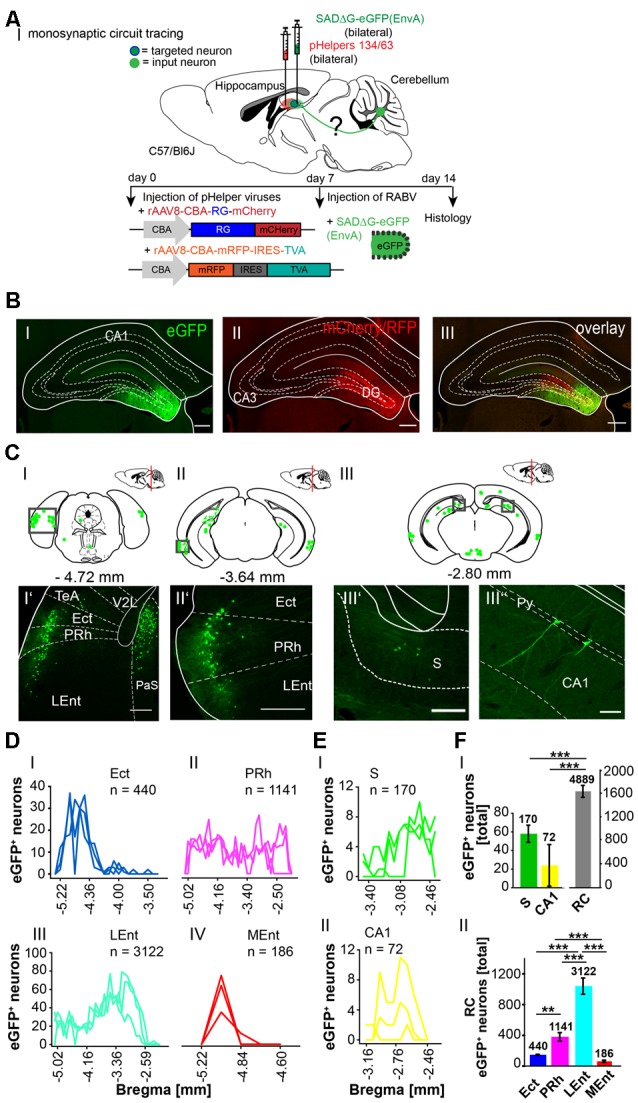
Mapping monosynaptic input areas to the dentate gyrus in C57/Bl6 mice using the retrograde SADΔG-eGFP tracer. (AI) Scheme of a sagittal section from an adult mouse brain injected with the retrograde specific RABV tracer (green circle) in the dentate gyrus of C57/Bl6 mice (n = 3). The pHelper viruses rAAV8-CBA-RG-mCherry and rAAV8-CBA-mRFP-IRES-TVA (1:2 ratio, 0.2 μl) were injected 7 days prior to the SADΔG-eGFP (EnvA) rabies virus (0.2 μl). (B) Confocal image showing one exemplary injection site in the left DG with rabies virus (eGFP, BI) and pHelpers (mcherry, BII) in the DG. Overlay reveals coinfected starter neurons for monosynaptic retrograde tracing (BIII). Scale bars: 250 μm. (CI–III) Coronal brain sections at −4.72 mm, −3.64 mm and −2.80 mm from Bregma depicting eGFP+ neurons (green dots) by retrograde monosynaptic transport from the DG. (CI–III”) Confocal image from boxed area presented in CI representing several eGFP+ neurons in the outer layers of the RC, including Ect, PRh and LEnt (CI’–II’), the S (CIII’) and pyramidal CA1 cells of the hippocampus (CIII”), representing input to the DG. Scale bars: 250 μm. (D) Line plots mapping the individual distribution of eGFP+ neurons by retrograde monosynaptic transport from the DG to the Ect (DI), PRh (DII), LEnt (DIII) and MEnt (DIV) in all mice. Each line represents the count of eGFP+ cell bodies in one mouse. (E) Line plots mapping the individual distribution of eGFP+ neurons by retrograde monosynaptic transport from the DG to the S (EI) and CA1 (EII). (FI) Compared to S and CA1, the RC provides the most input to the DG revealed by monosynaptic retrograde transport (t-test, for S: p ≤ 0.001; for CA1 p ≤ 0.001). (FII) Within the RC, the LEnt forms significantly more synapses with the DG with a total of 3,122 eGFP+ cells compared to PRh (p ≤ 0.001), Ect (p ≤ 0.001) and MEnt (p ≤ 0.001, all One-Way-ANOVA). In the PRh a total of 1,141 cells was counted and is the second strongest input source to the DG compared to Ect (p = 0.006) and MEnt (p = 0.001, One-Way-ANOVA).Significance for comparisons: **p ≤ 0.01; ***p ≤ 0.001.DG, dentate gyrus; Ect, ectorhinal cortex; LEnt, lateral entorhinal cortex; MEnt, medial entorhinal cortex; PRh, perirhinal cortex; Py, pyramidal cell layer of the hippocampus; RC, rhinal cortex; S, subiculum; TeA, temporal association cortex; V2L, secondary visual cortex, lateral area. The mouse brains in this figure has been reproduced from Franklin and Paxinos (2001).